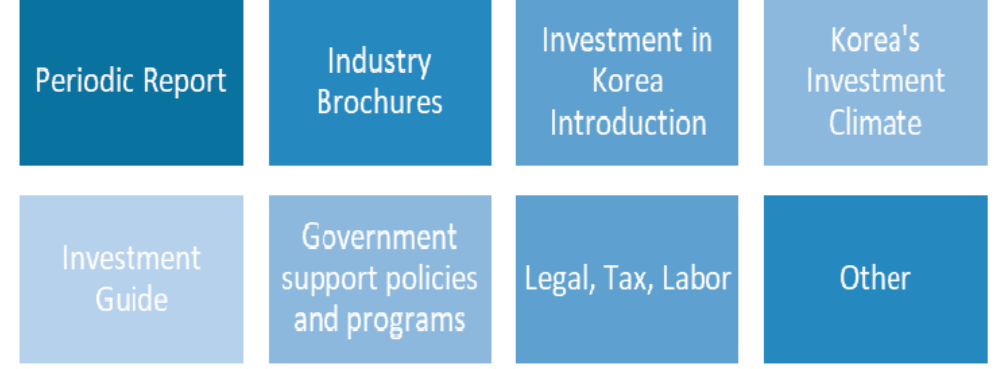
Figure 3. Information that new foreign investors in Korea.